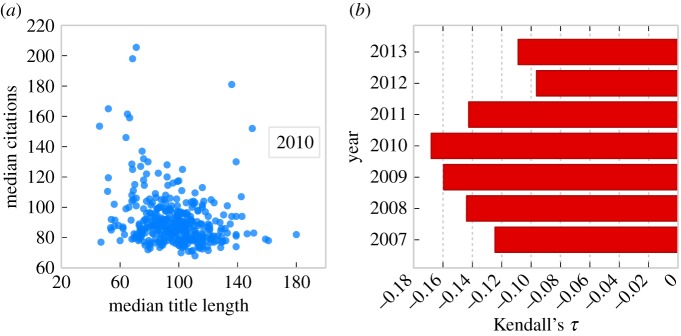
Paper title length and citations received, analysed at journal level. (a) For each journal in 2010, we plot the median citations for a paper against the median title length. We find that journals which publish papers with shorter titles receive more citations per paper (Kendall's τ=−0.19, p<0.001, N=361). (b) Parallel analyses of the data for each year between 2007 and 2013 confirm that this relationship holds across all 7 years of data (2012: τ=−0.1, N=320, p<0.05; 2013: τ=−0.11, N=352, p<0.01; all other years: all τs≤−0.14, all ps <0.001, α=0.05; Kendall's τ correlation with FDR correction).